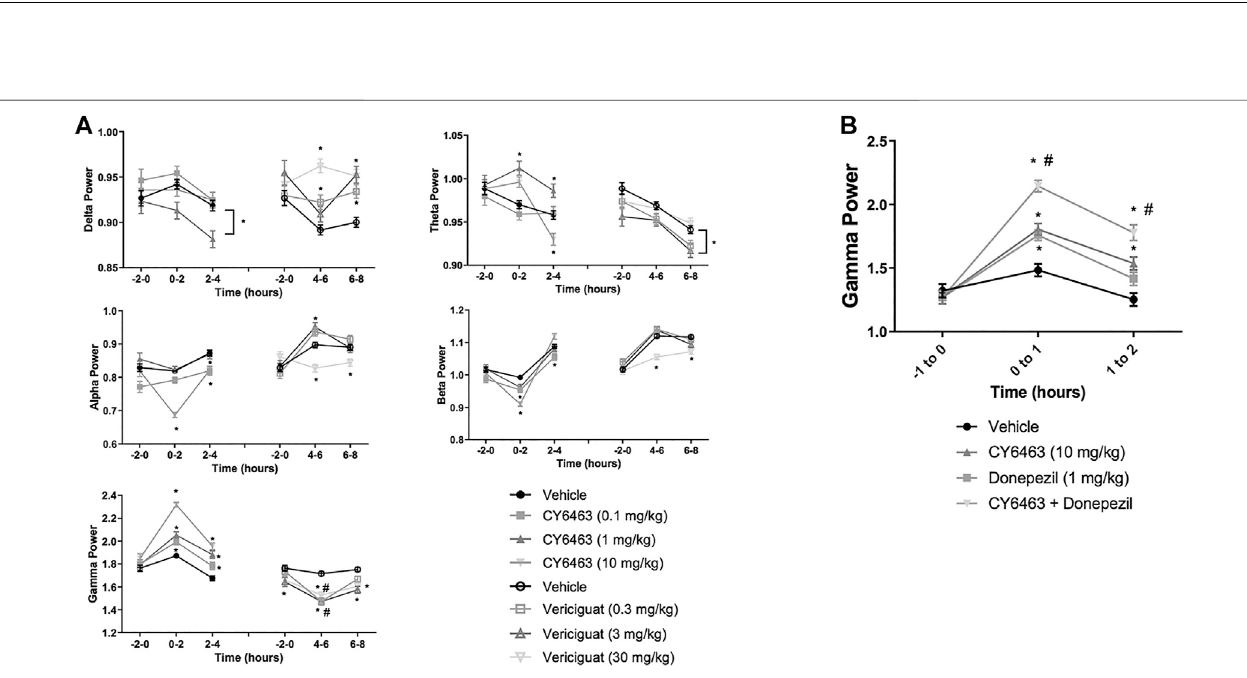
Frontiers in Pharmacology |